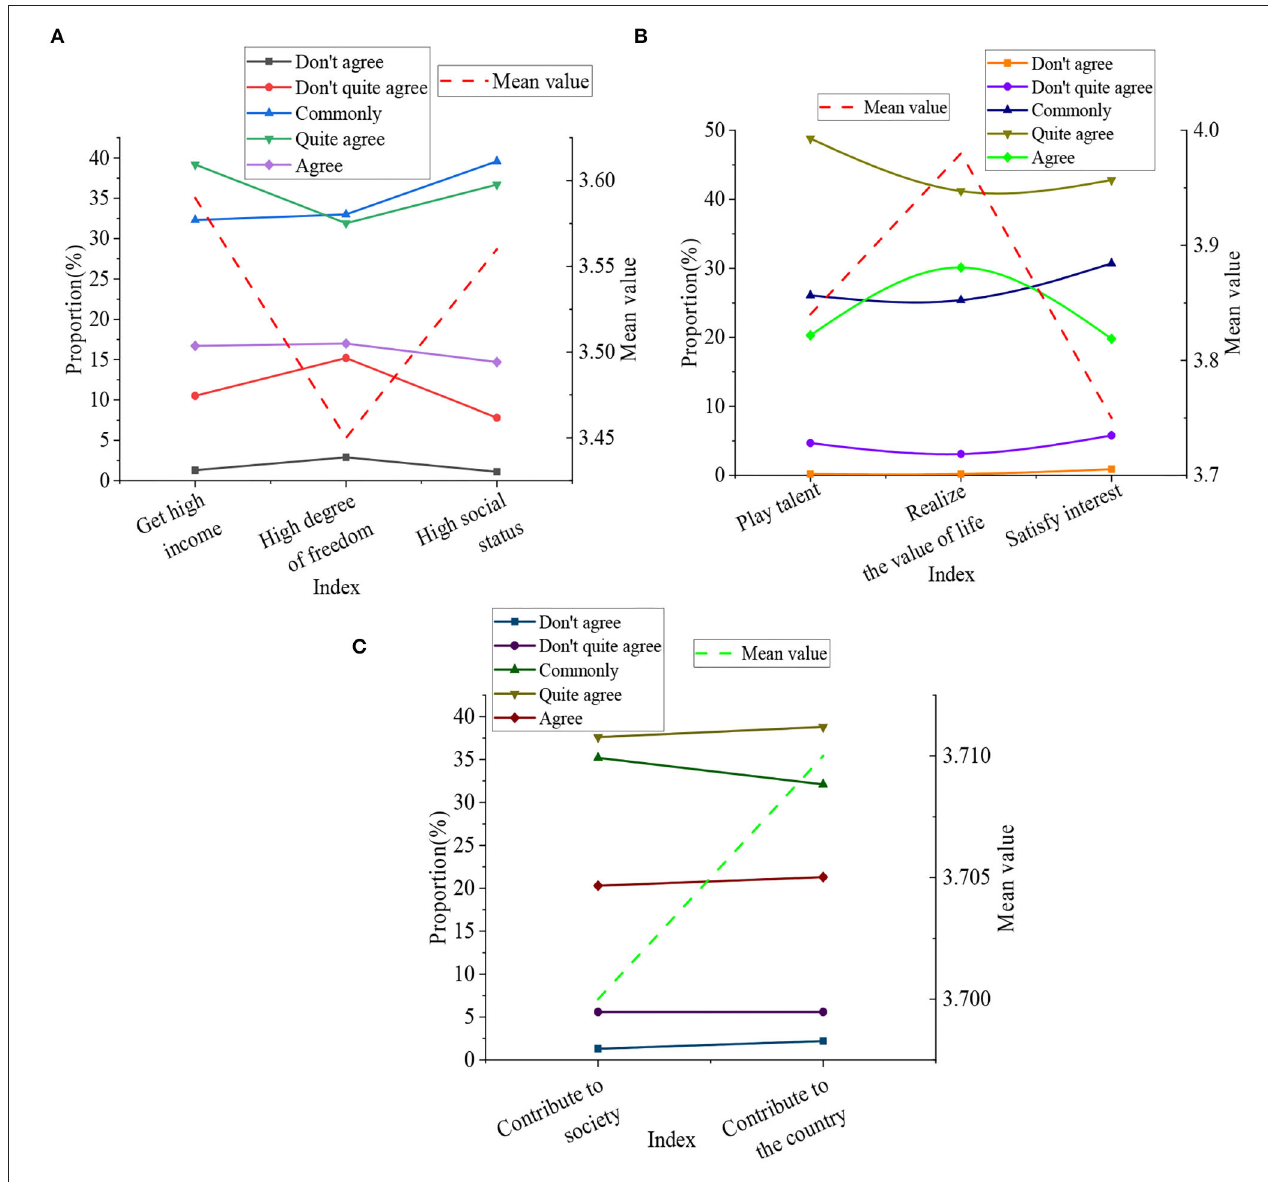
FIGURE 9 | Basic situation of college students’ entrepreneurship values. (A) shows the type of personal survival. (B) is the type of personal development. (C) means the type of social